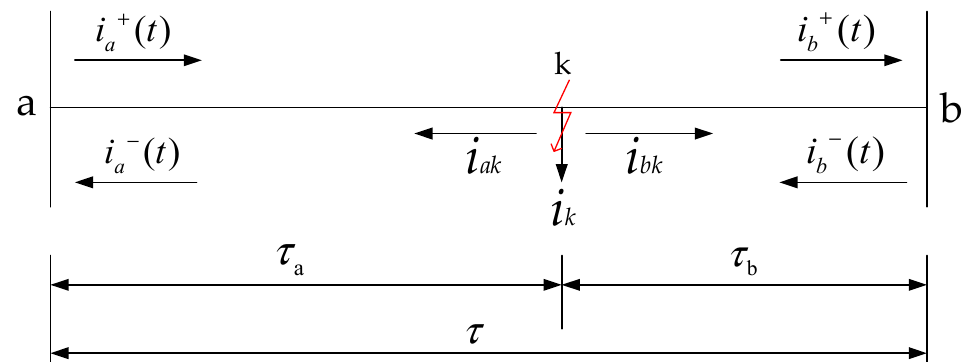
Figure 1. Schematic diagram of uniform DC line.